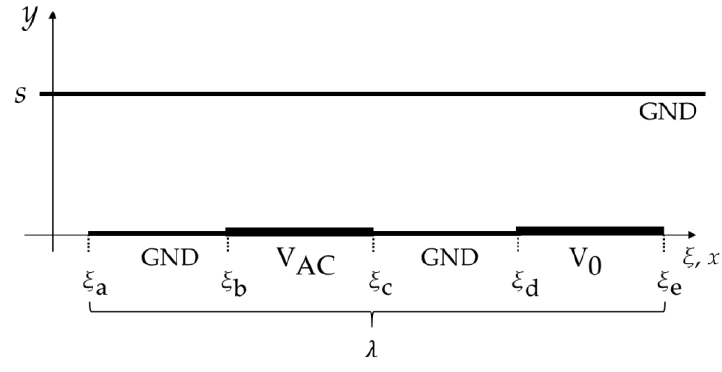
Figure 2. Cross section of IDS for the calculation with Green’s function. Shown is one period of λ .